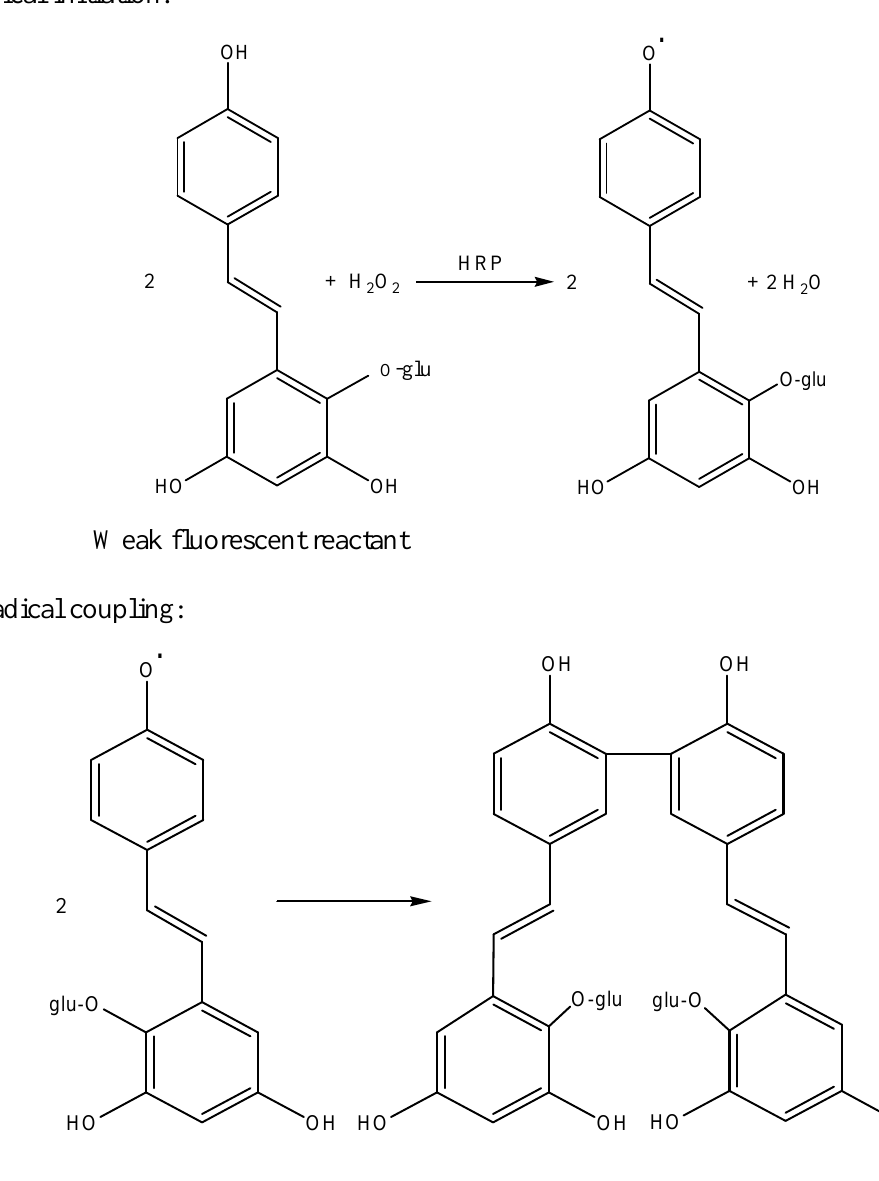
Figure 4. Mechanism skeleton of HRP-catalyzed reaction using TBG as fluorogenic